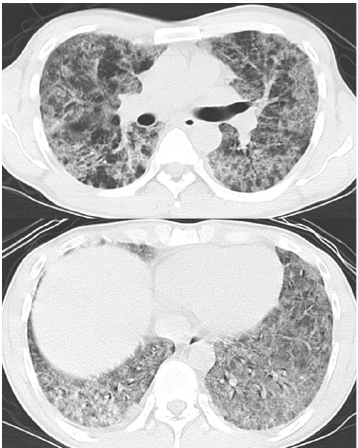
Figure 2: Chest computed tomography revealed bilateral airspace consolidation and ground-glass